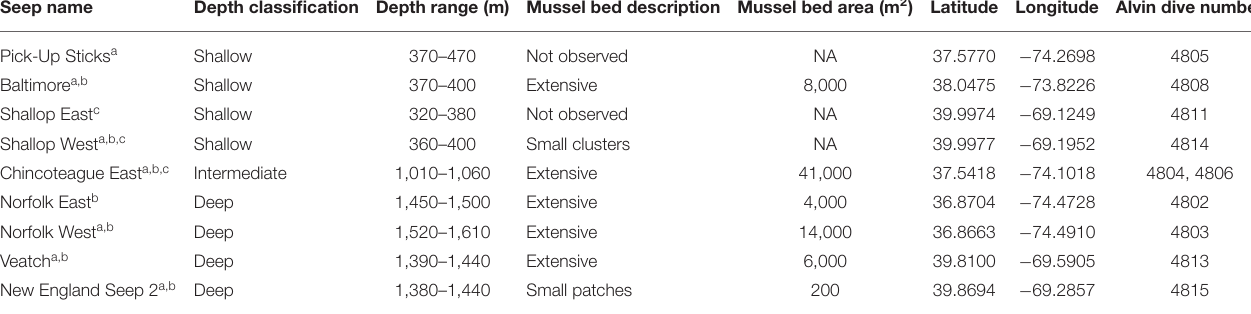
TABLE 1 | US Atlantic margin seep